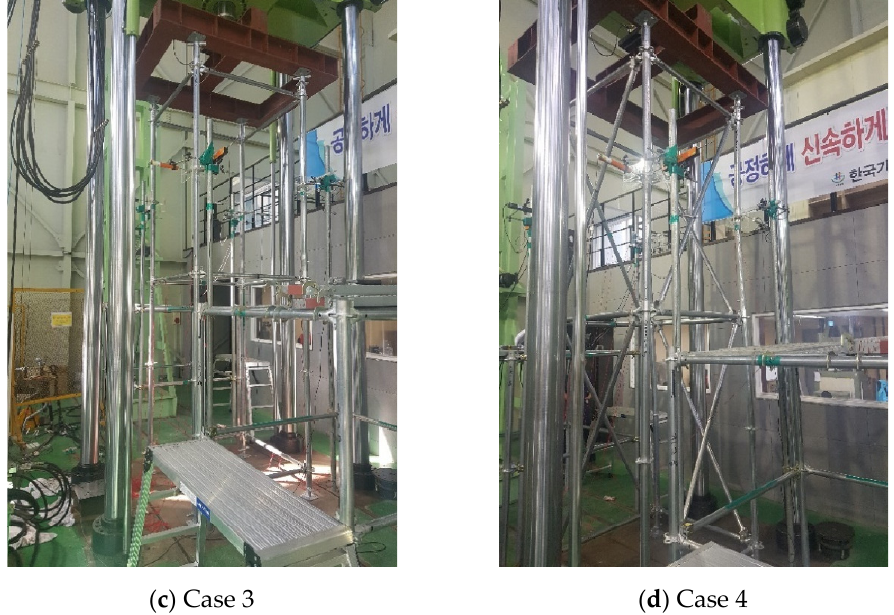
Figure 3. Prefabricated shoring system installation for Cases 1–4.